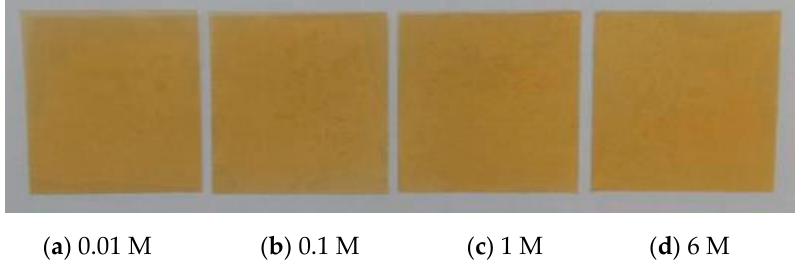
Figure 3. Color change of the CMX test pieces immersed in solutions of different NaOH concentrations for 1 h at 25 °C.